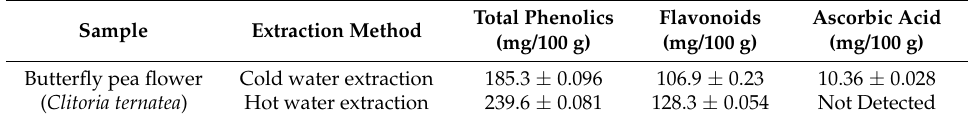
Table 2. Contents of total phenolics, flavonoids, and ascorbic acid in the butterfly pea flower